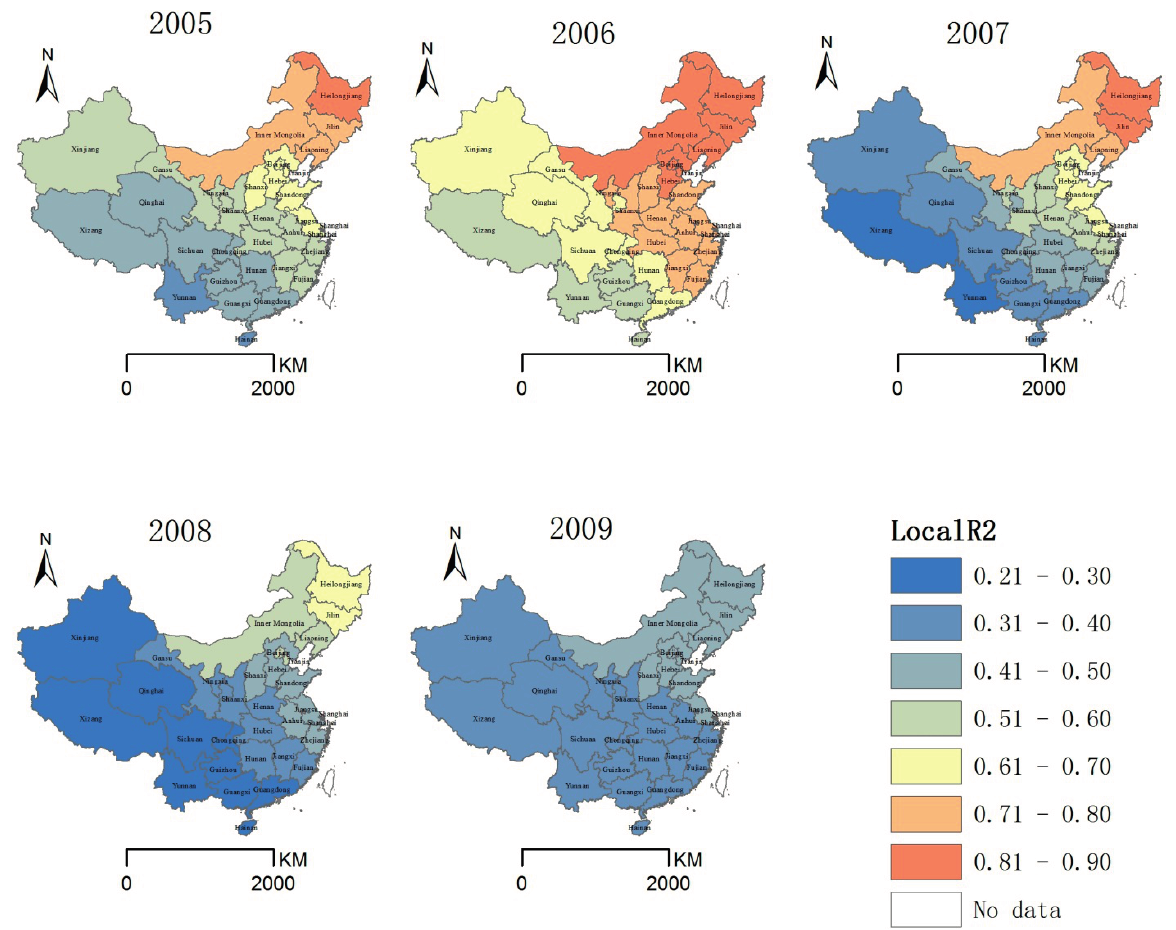
Figure 4. Distribution of GWR local R 2 values,